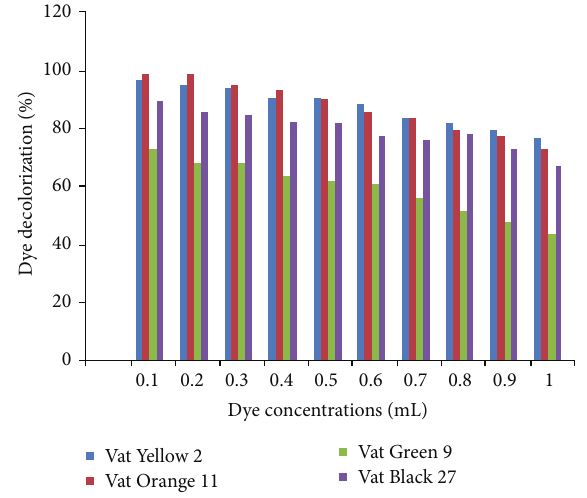
Figure 13: Percent decolourization as a function of dye concentra-